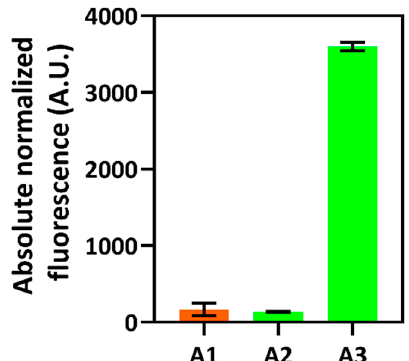
Figure 5. Screening of tnaA -positive strains. Absolute normalized fluorescence of C. necator strains harboring inducible system Pp TrpI/P PP_RS00425 only (control, A1) and inducible system Pp TrpI/P PP_RS00425 with tnaA gene (A2 and A3). Data are mean ± SD, n = 3.